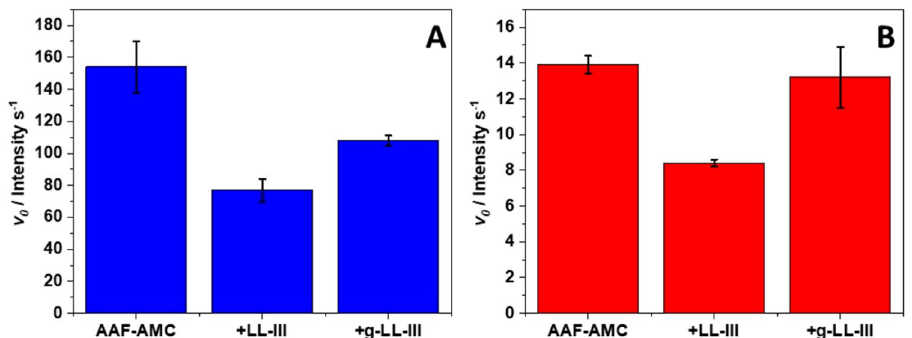
Figure 7. Initial rates ( v 0 / Intensity s −1 ) for the hydrolysis of the substrate AAF-AMC catalyzed by ( A ) α-chymotrypsin at pH 7.4 and ( B ) pepsin at pH 4.0, in the absence and in the presence of LL-III and g-LL- III peptides. The concentration of α-chymotrypsin and pepsin were 10 nM and 5 µM, respectively. The